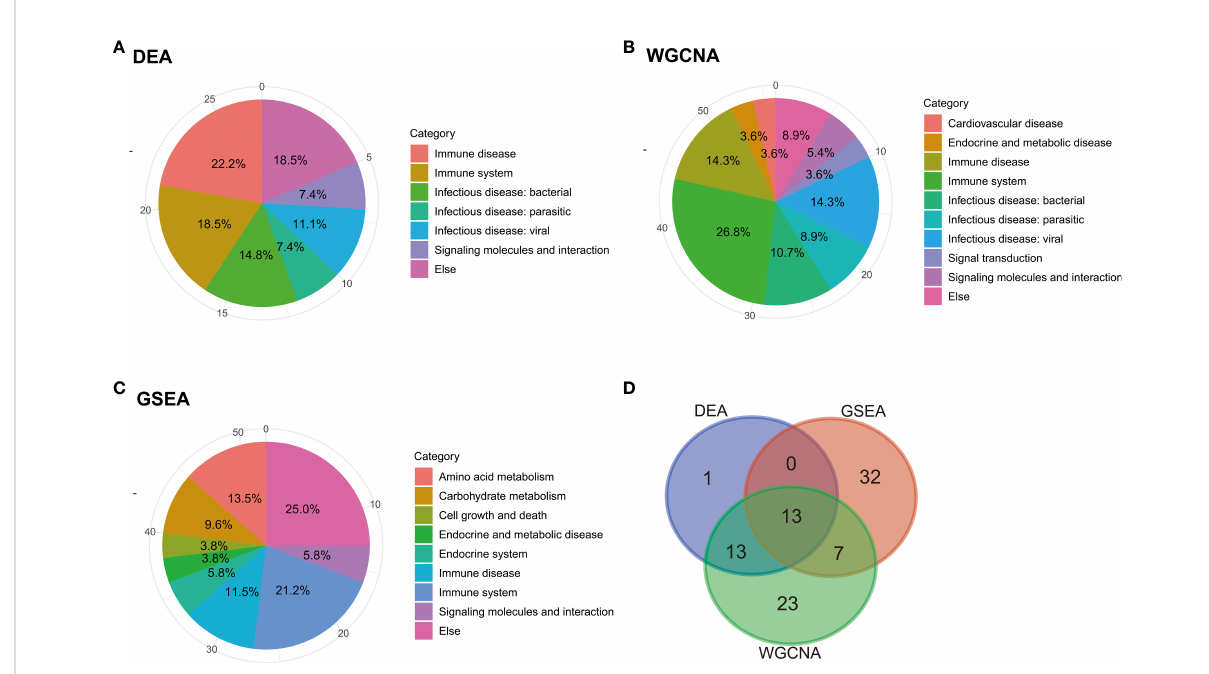
FIGURE 5 Categorization and intersection of pathway enrichment analysis. Pie charts of categorization of pathway enrichment analysis based on the results of (A) KEGG, (B) GSEA, and (C) WGCNA. (D) Venn diagram of pathways based on the three enrichment analysis methods: KEGG, GSEA, and WGCNA.